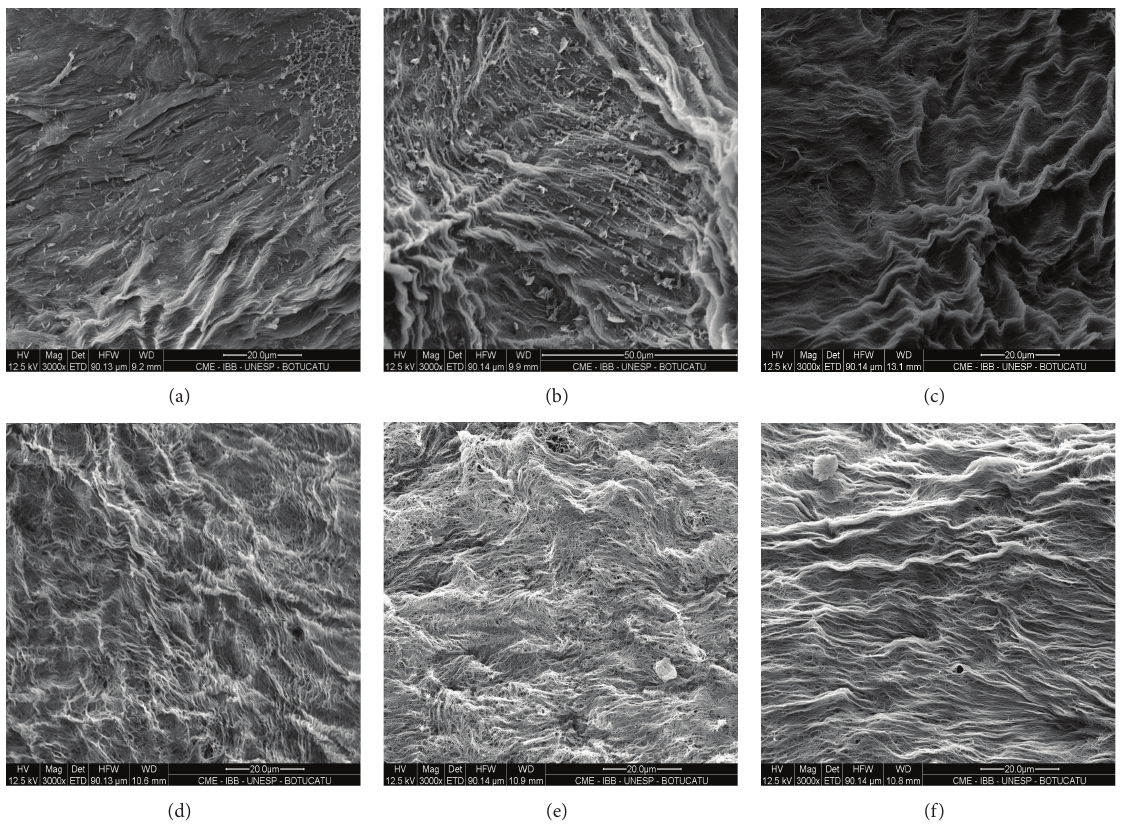
Figure 6: Photomicrographs of surgical scars from the skin of normal rat ((a), (b), and (c)) and diabetic ((d), (e), and (f)), sacrificed on postoperative day 21, showing organized deposition of dense, wavy provisions collagen horizontally on the epithelial surface, surgical wounds in rats of NG/NT (a), NG/CEC (b), NG/Zn + TDI (c), and DG/Zn + TDI (f). Note that this ultrastructural pattern of collagen deposition was not observed in scars of untreated (d) or treated with CEC alone (e) (EM - 3000x) diabetic rats.